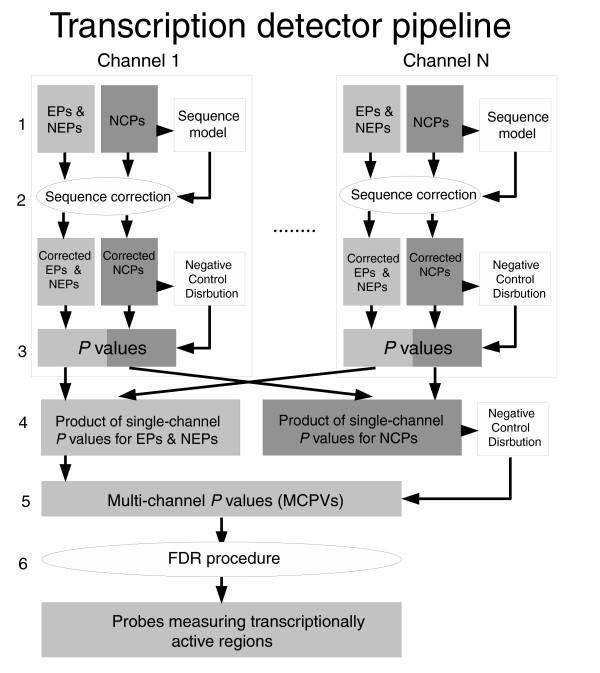
Schematic overview of the TranscriptionDetector data processing pipeline. First, a model accounting for the effect of probe sequence on non-specific binding is fit to the (log-transformed) NCP signal intensities ('step 1') and used to correct the intensity for all probes ('step 2'); a separate model is fit for each channel. For each probe, we then derive a p value reflecting the likelihood that its signal intensity belongs to the background distribution represented by the NCPs ('step 3'); these p values are calculated separately for each channel, and each channel-specific p value is treated as the outcome of an independent experiment. A multi-channel statistic equal to the product of p values across all channels is computed for each probe ('step 4'). In analogy with step 3, the distribution of this statistic for the NCPs only is then used to assign a MCPV to the other probes ('step 5'). To control for multiple hypothesis testing, a FDR procedure is used, and each probed locus is designated as transcribed or not transcribed ('step 6').